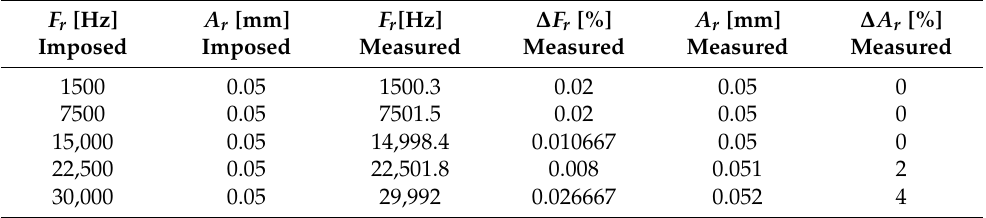
Table 1. A comparison between the imposed and measured resonance frequency ( F r ) and amplitude ( A r ) is shown. The percentage difference between the two is reported ( ∆ F r and ∆ A r ). The resonance amplitude is kept constant at 0.05 mm.